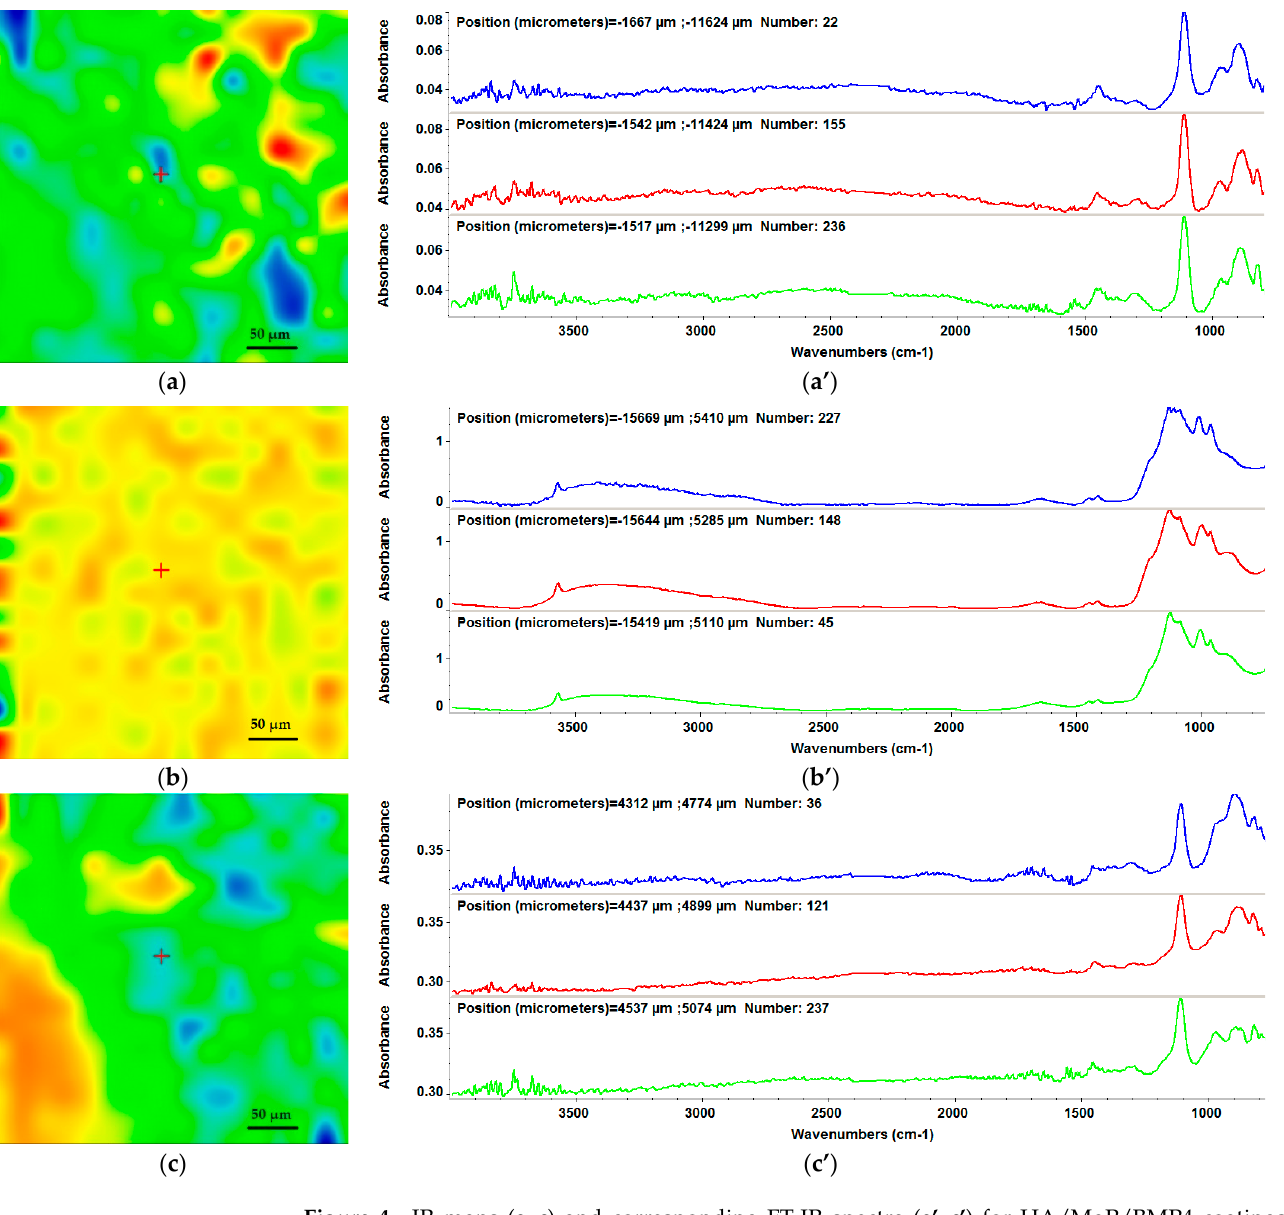
Figure 3. IR map ( a ) and corresponding FT-IR spectra ( b ) assigned to the phosphate group for the drop-cast reference material.